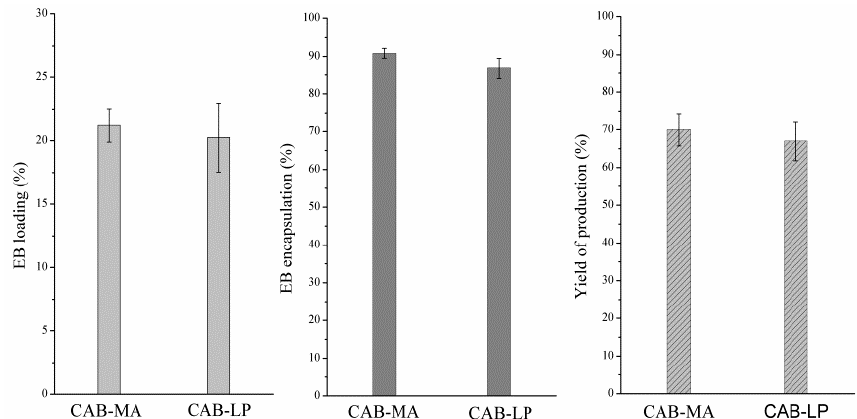
Figure 7. The results of emamectin benzoate (EB) loading, entrapment rate, and yield of production ( n = 3).